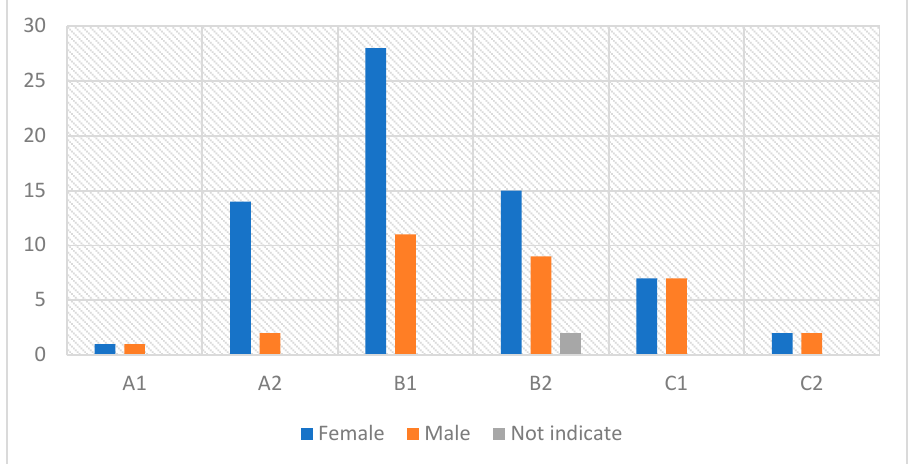
Figure 2. Level of Digital Competence by Gender.